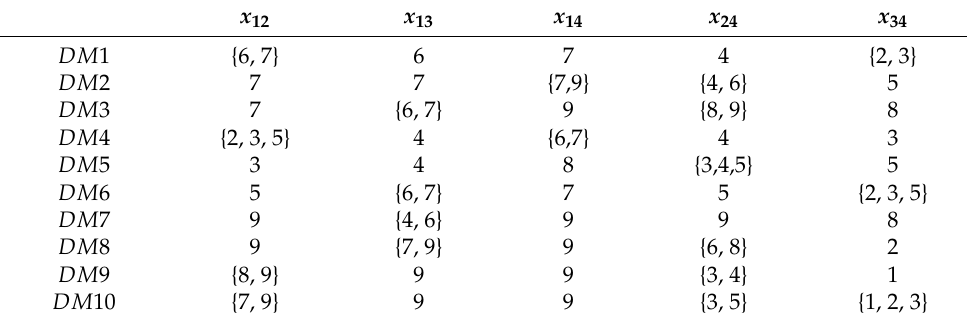
Table 11. Case study.